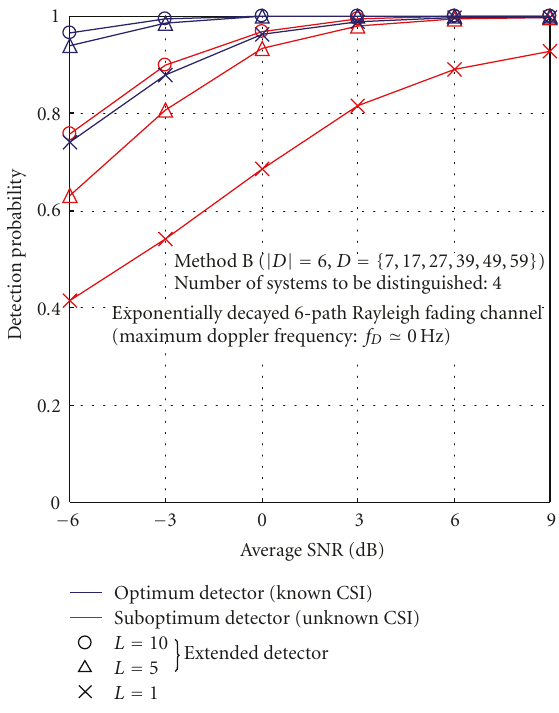
Figure 11: Performance for Method B: extended optimum and suboptimum detection with L = 1,5 and